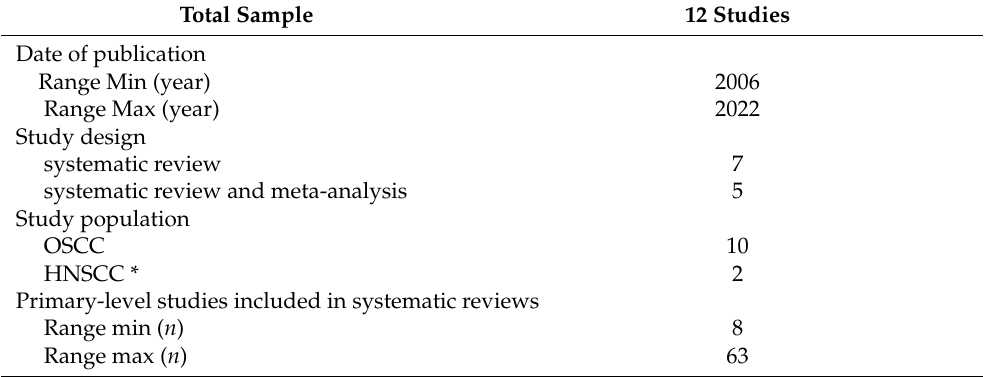
Table 1. Study sample characteristics of systematic reviews and meta-analyses included in this scoping